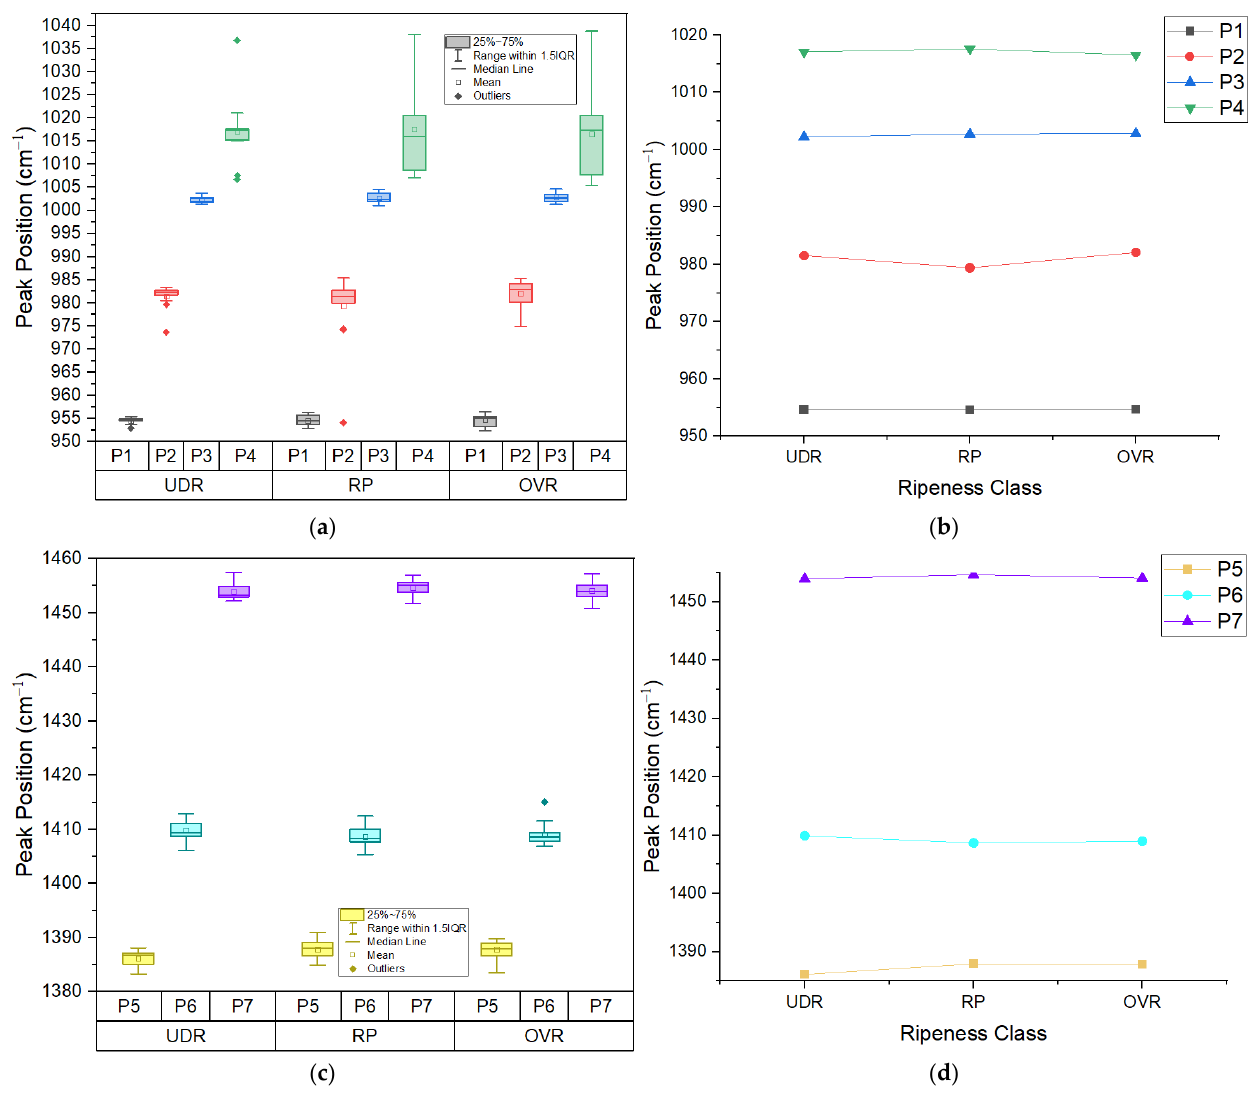
Figure 5. ( a ) Grouped box plot and ( b ) mean plot of peak’s position of 4 peaks in Area 1; ( c ) Grouped box plot and ( d ) mean plot of peak’s position of 3 peaks in Area 2. UDR: Under ripe, RP: Ripe, OVR: Over ripe; P1: β-carotene, P2: chlorophyll-a, P3: β-carotene, P4: amino acid, P5: β-carotene, P6: cuticular wax, P7: lycopene/β-carotene.